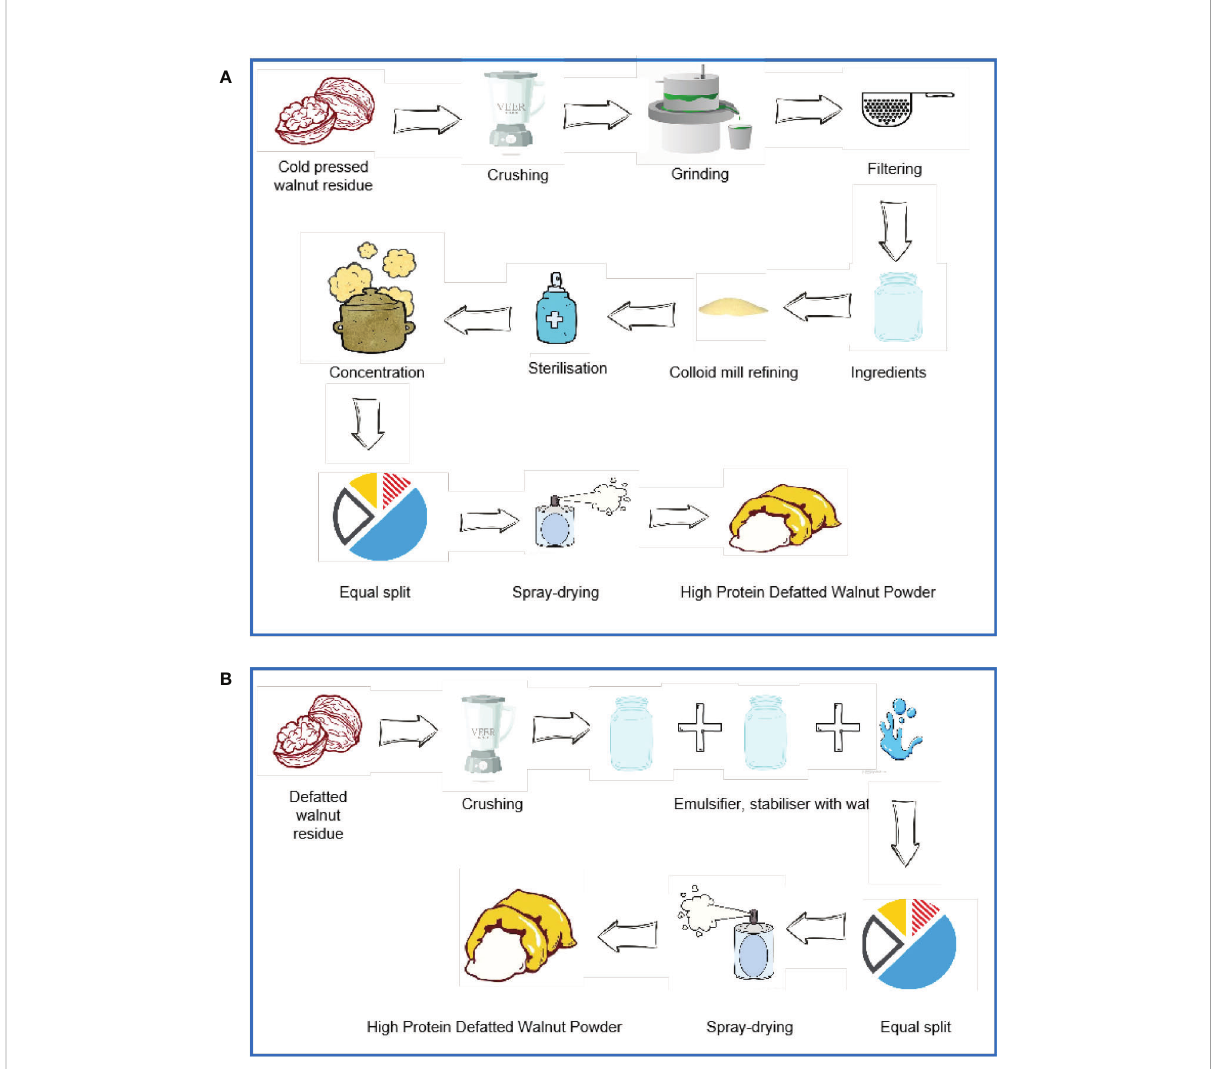
FIGURE 3 There are two main ways of preparing low-fat walnut protein powder. (A) The method of using the cold-pressed walnut residue as raw material. (B) The method of using Xinjiang high-quality walnut defatted residue as raw material.